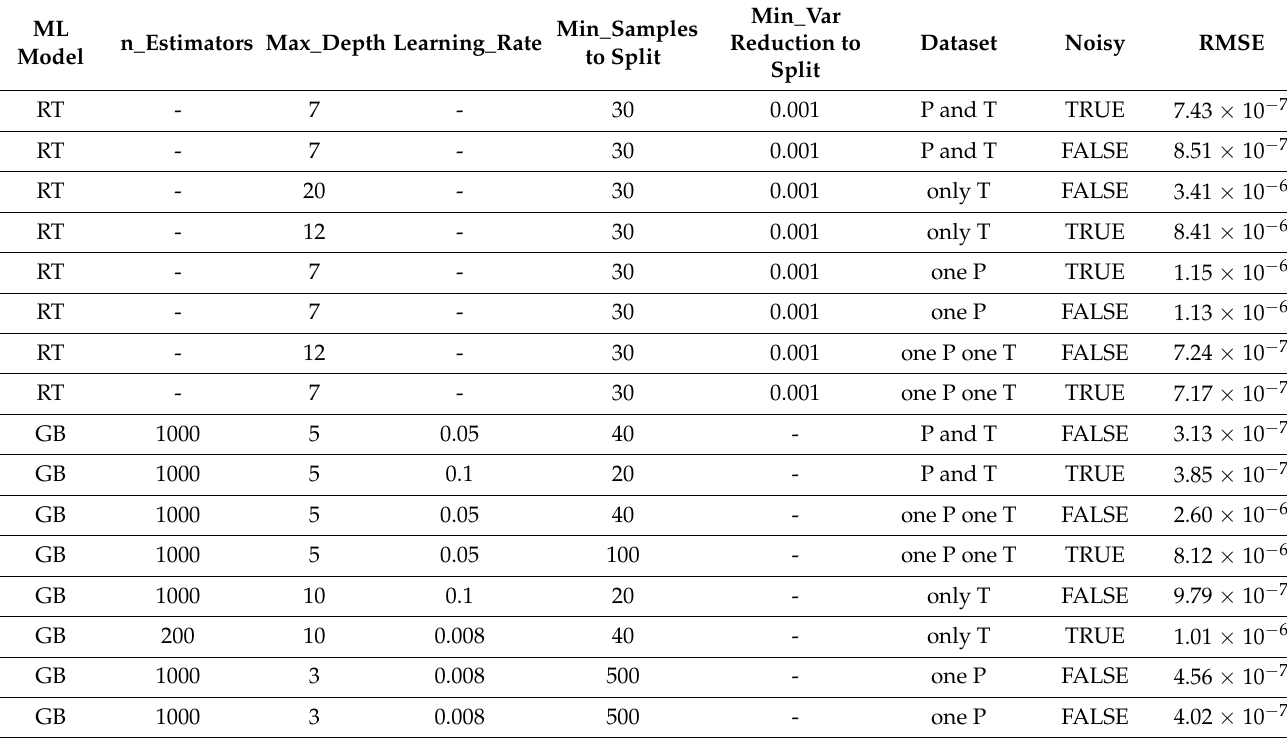
Table A1. Tuned hyperparameter values for each ML